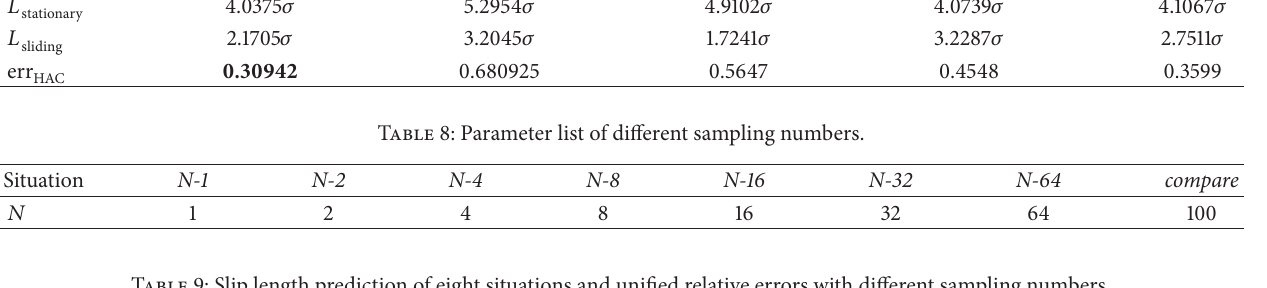
Table 9: Slip length prediction of eight situations and unified relative errors with different sampling numbers.